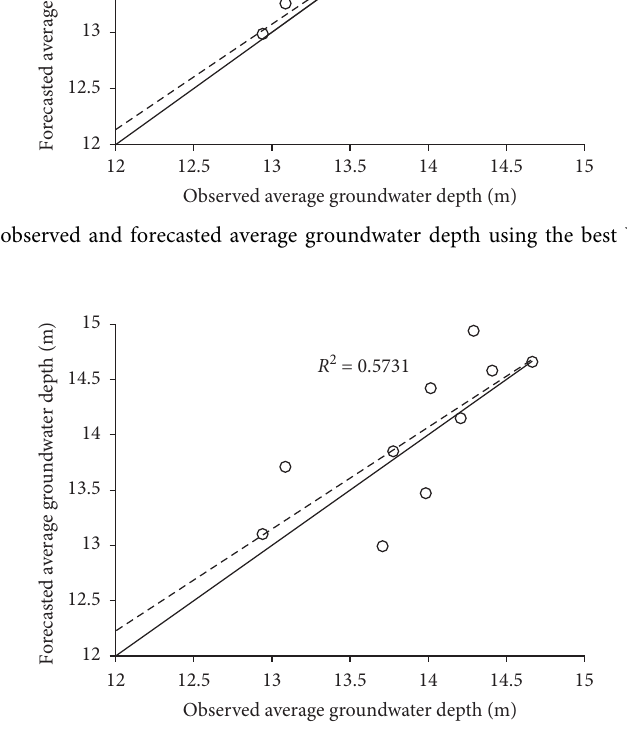
Figure 9: Scatterplot comparing observed and forecasted average groundwater depth using the best ARIMA model during the testing period.